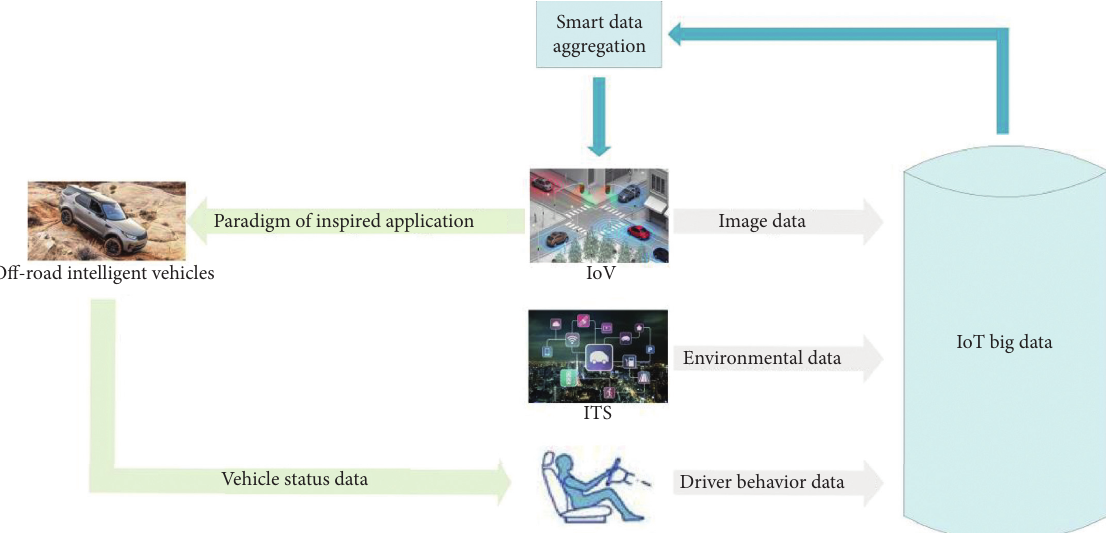
Figure 1: Smart data aggregation inspired paradigm of IoT